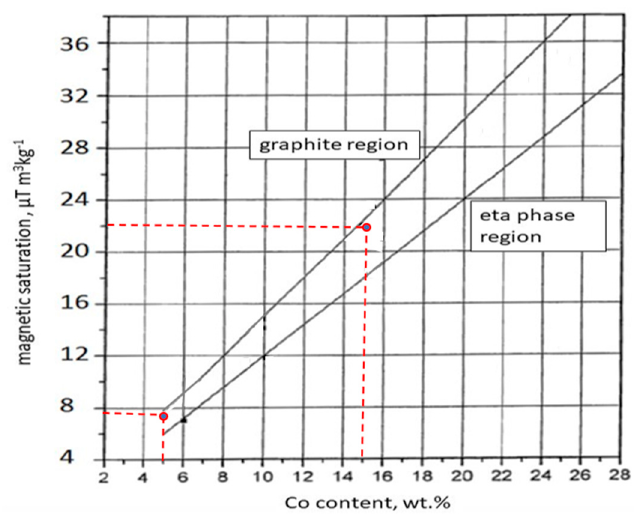
Figure 8. Influence of magnetic saturation and Co content on the appearance of graphite and eta phase in quality control of cemented carbides [31].